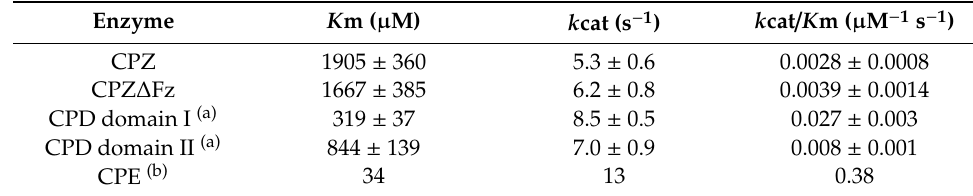
Table 1. Kinetic constants for the hydrolysis of dansyl-Phe-Ala-Arg by different metallocarboxypeptidases (MCPs) with B-like CP